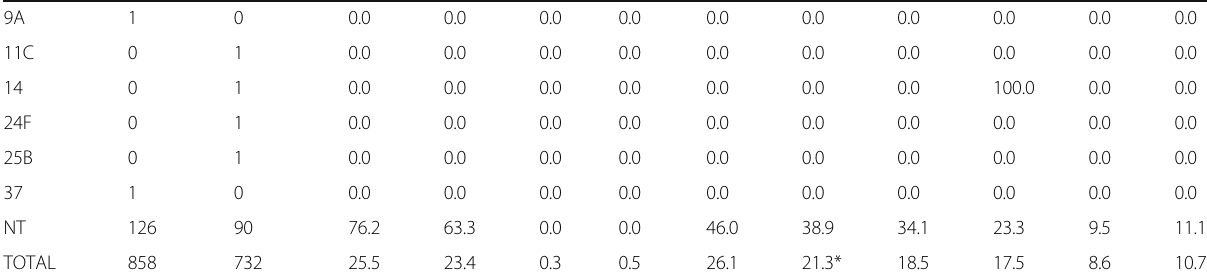
Table 2 Frequencies of serotypes and antibiotic resistance rates found among 1590 isolates of Streptococcus pneumoniae among Aboriginal people in Western Australia, August 2008 – November 2014 . PCV13 was introduced on July 1 2011 (Continued)